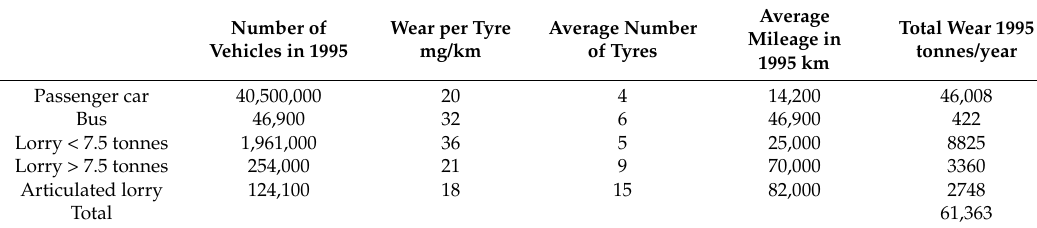
Table 7. Calculation of the amount of tyre wear and tear in Germany by Baumann and Ismeier